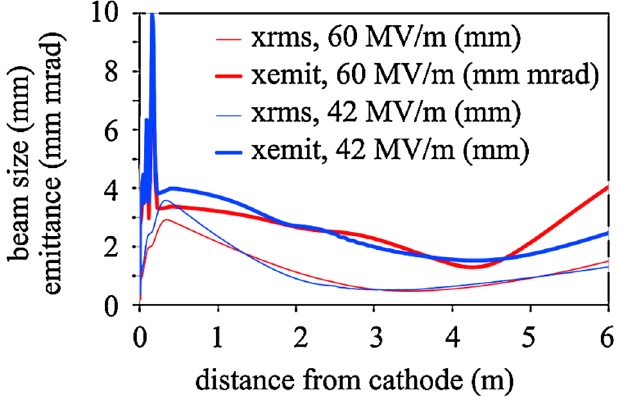
FIG. 32. (Color) Simulated normalized beam emittance and transverse rms size along the beam line for the optimized cases 42 and 60 MV = m peak field at the cathode.